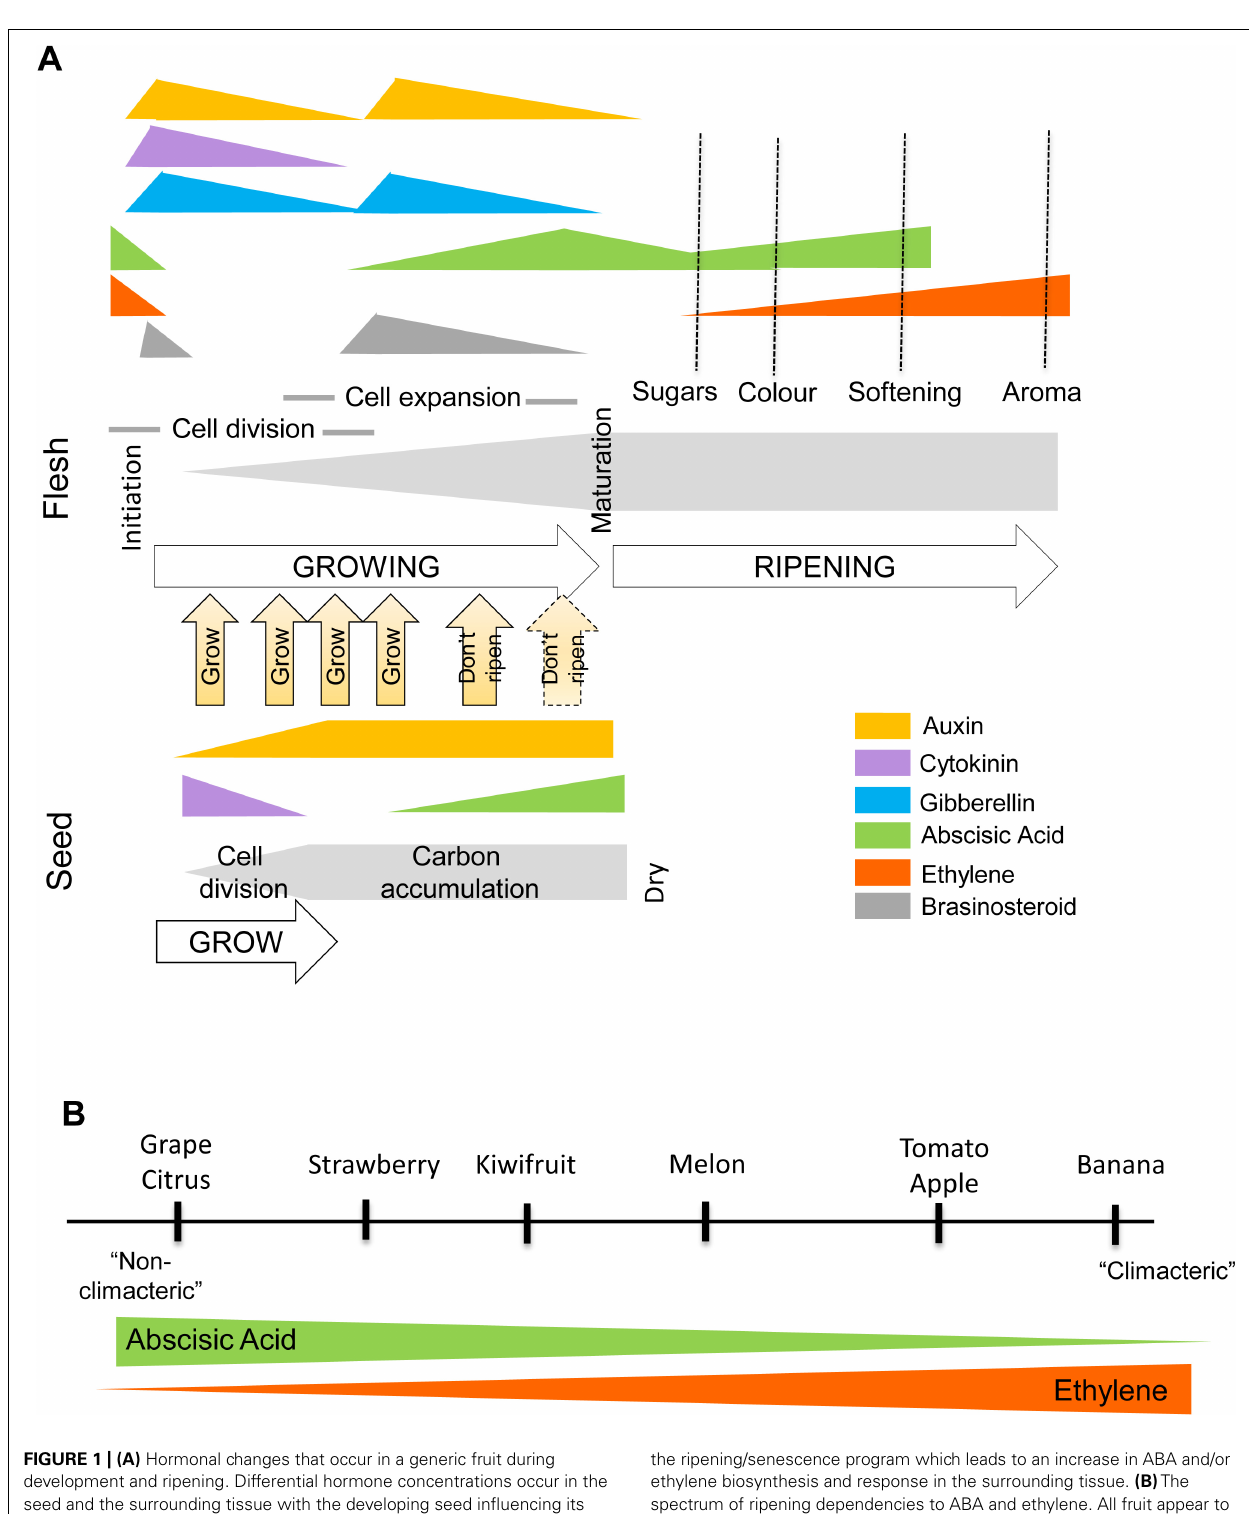
FIGURE 1 | (A) Hormonal changes that occur in a generic fruit during development and ripening. Differential hormone concentrations occur in the seed and the surrounding tissue with the developing seed influencing its environment. Multiple studies have shown that increases in auxin, cytokinin, gibberellin, and brassinosteroid at fruit set, and an involvement of auxin, gibberellin, and brassinosteroid at fruit growth. For fruit maturation there is an inhibition of auxin transport from the seed and increase in ABA.This triggers